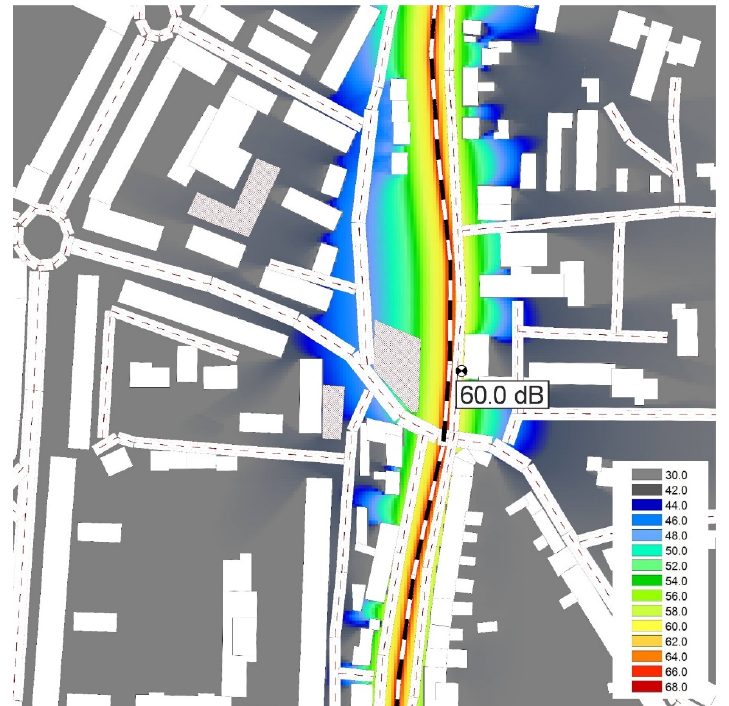
Figure 10. Noise map ZV1.